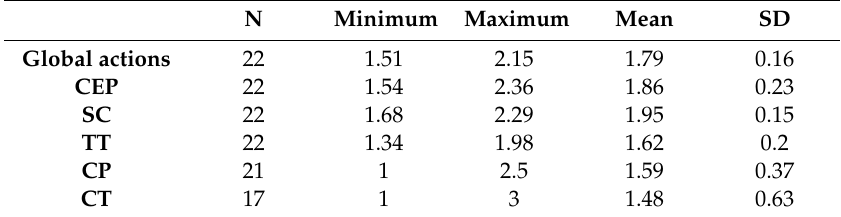
Table 3. General global means and means per